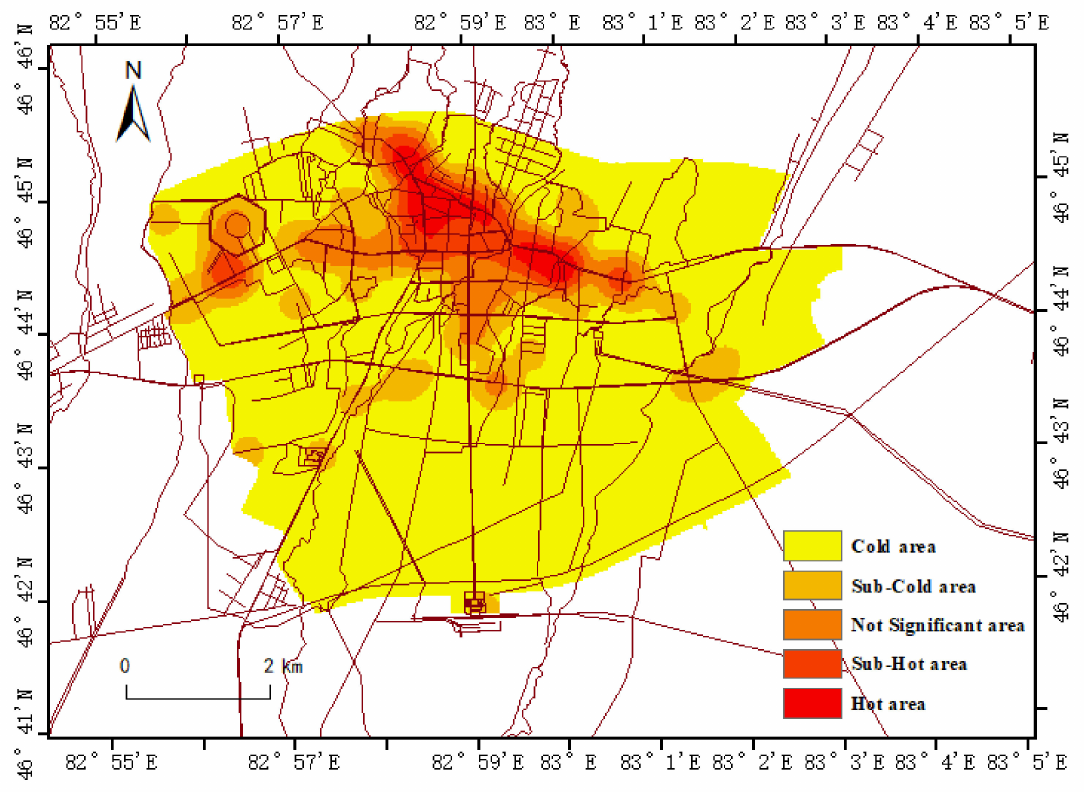
Figure 3. Life characteristics map of the population in the study